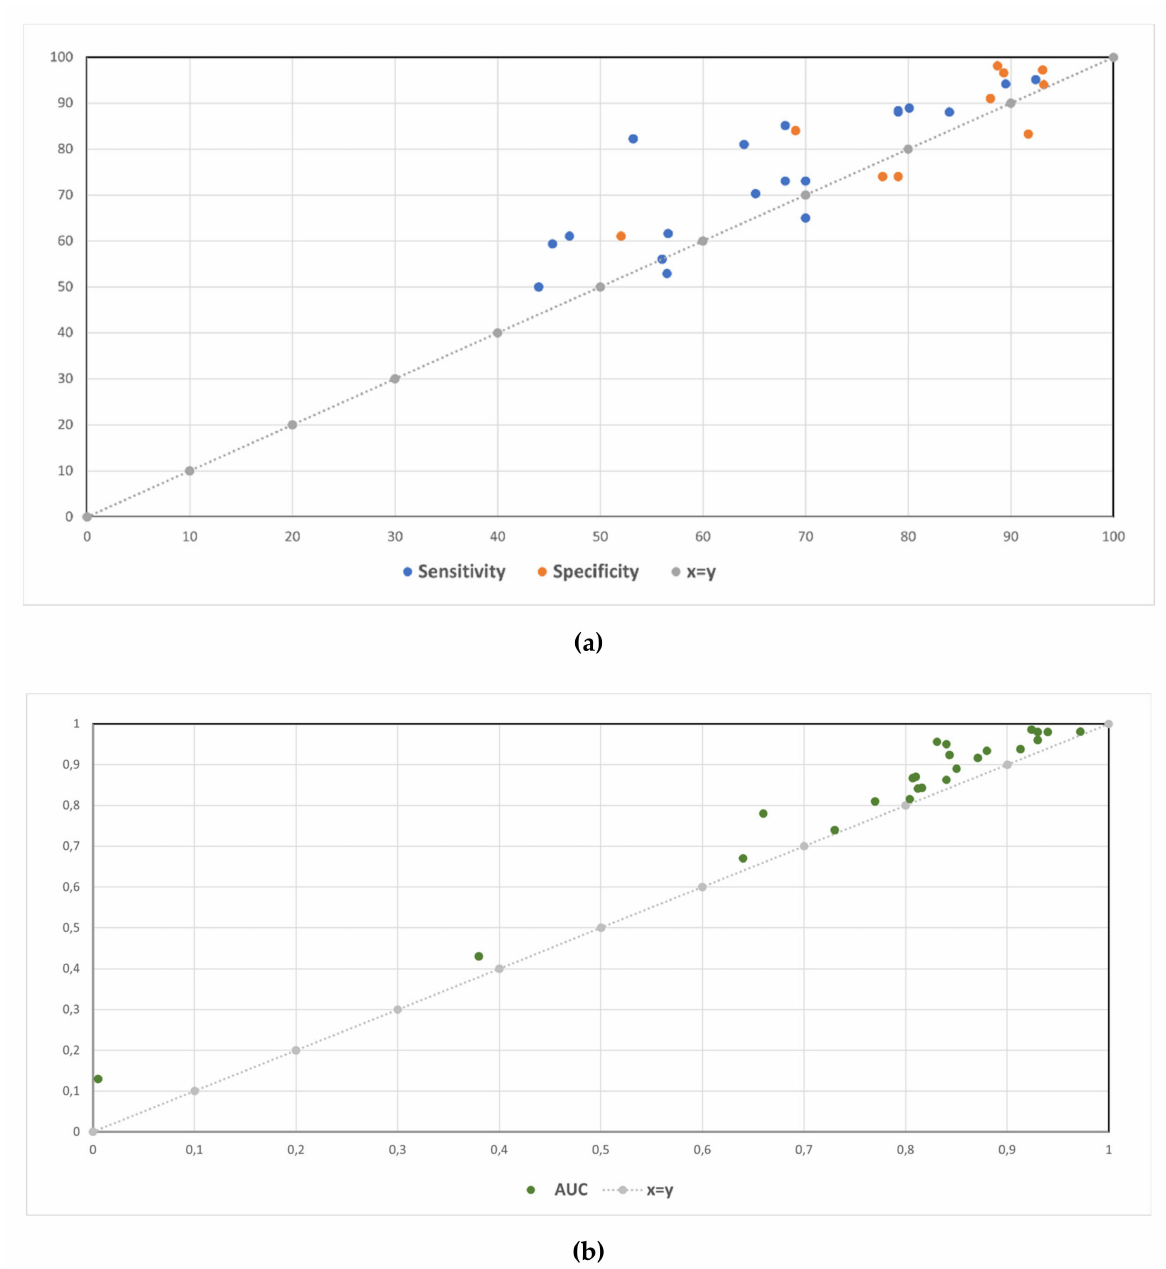
Figure 3. Sensitivity and specificity ( a ) and AUC ( b ) without and with the aid of an AI-based